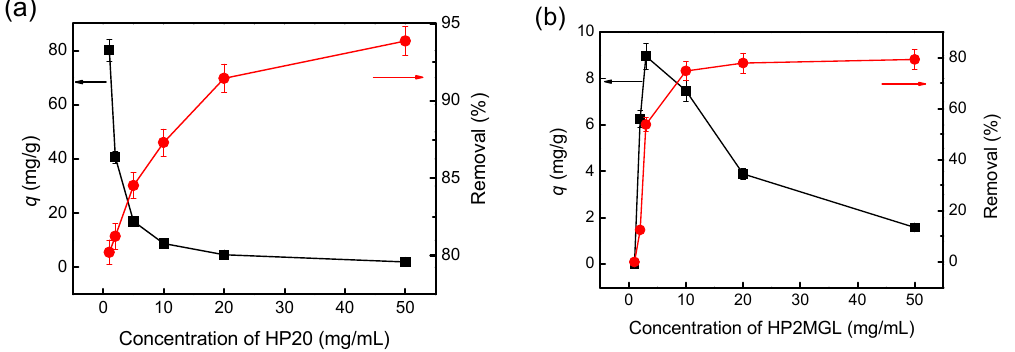
Figure 4. Effect of the concentrations of ( a ) HP20 and ( b ) HP2MGL on adsorption efficiency of SDBS. [SDBS] = 0.1 mg/mL; adsorption time 7 h.